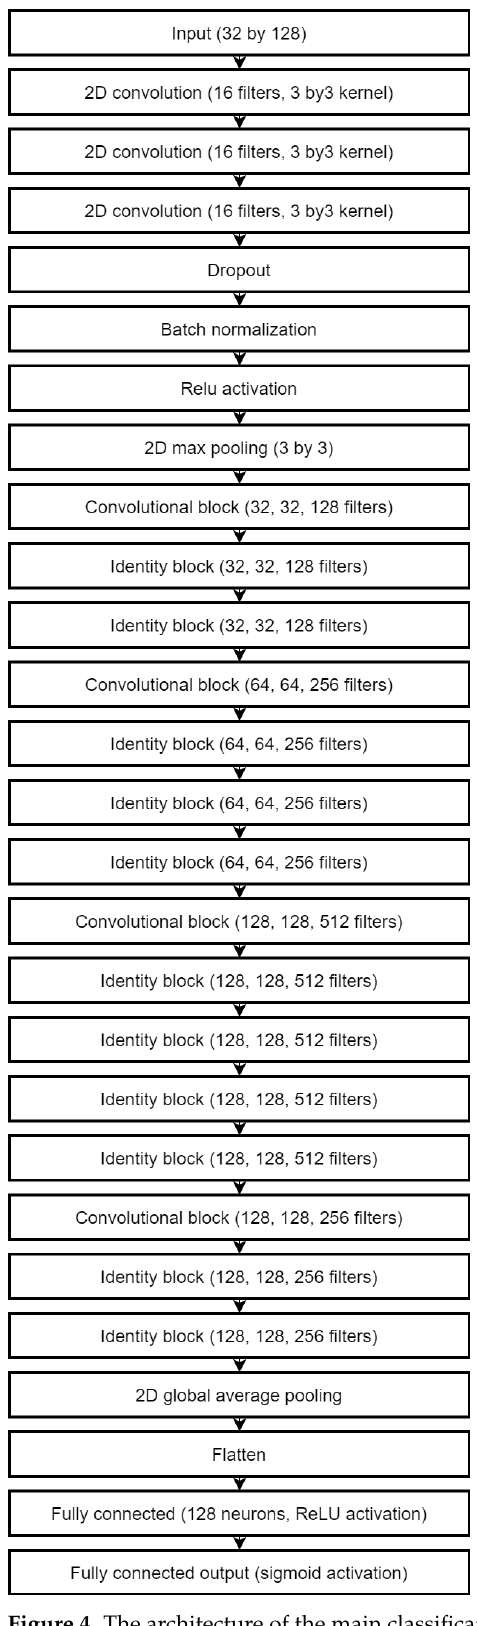
Figure 4. The architecture of the main classification